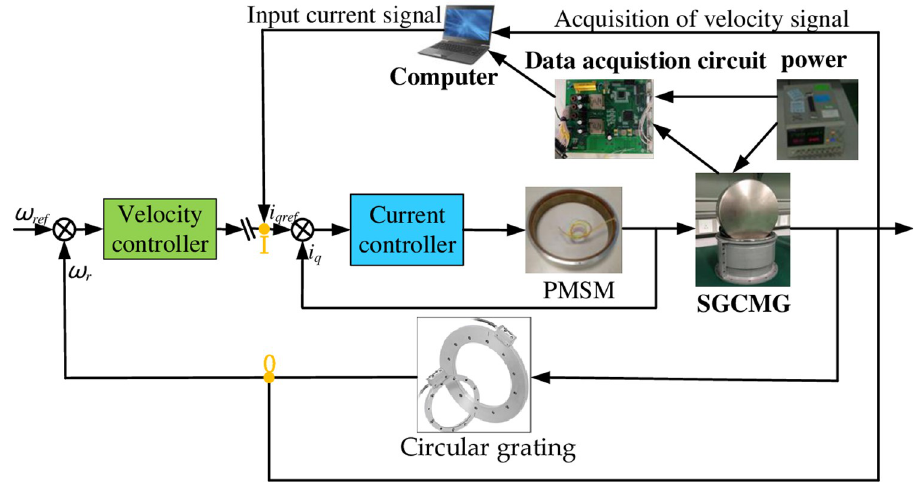
Fig 8. System identification principle diagram.